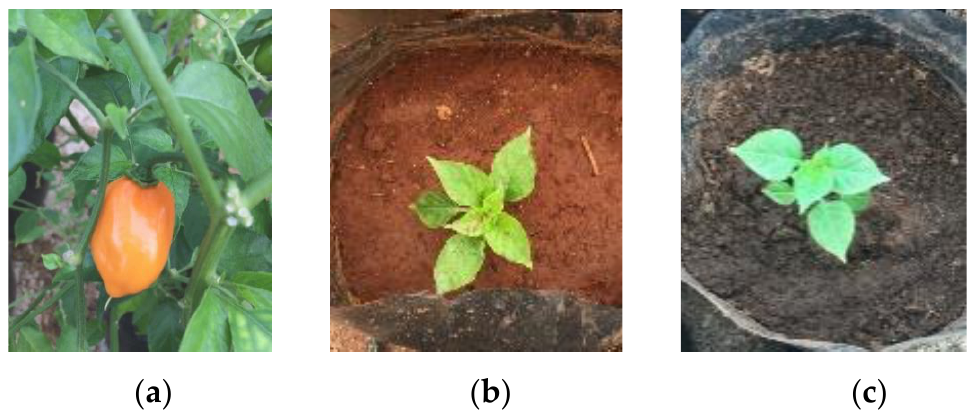
Figure 1. ( a ) Capsicum chinense (Jaguar variety), ( b ) C. chinense plant grown on red soil, and ( c ) C. chinense plant grown on black soil.